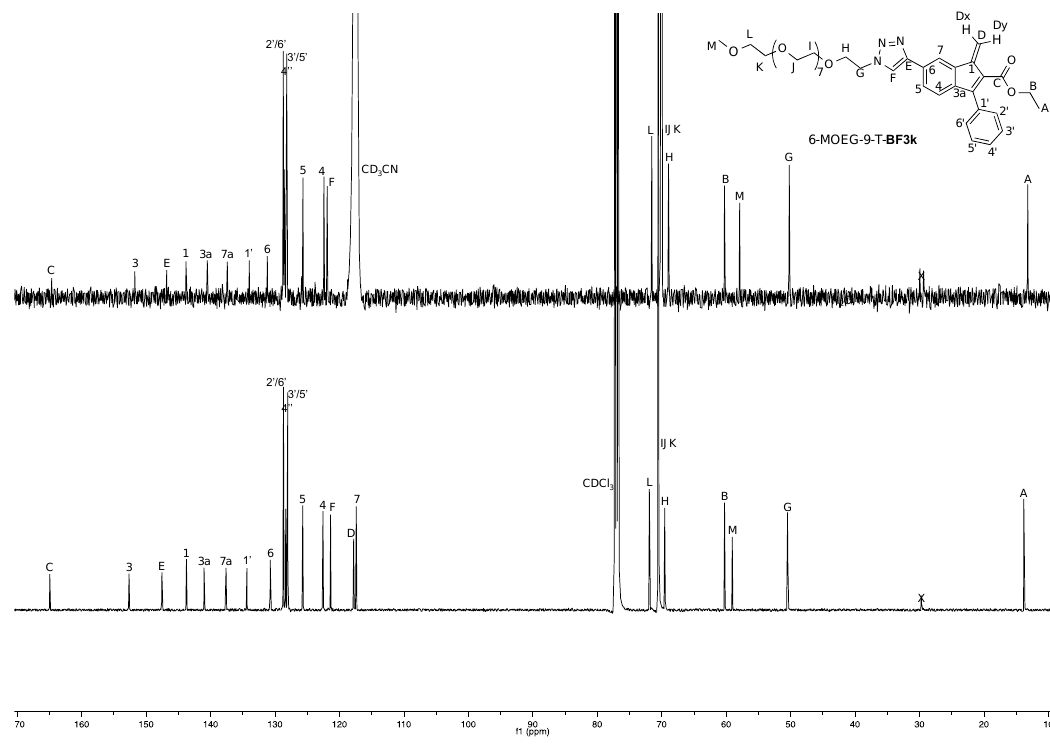
Figure 5. Comparison of the 13 C NMR spectra (125 MHz) of monomer 6-MOEG-9-T- BF3k acquired respectively in CDCl 3 (bottom trace) and in CD 3 CN (top trace).